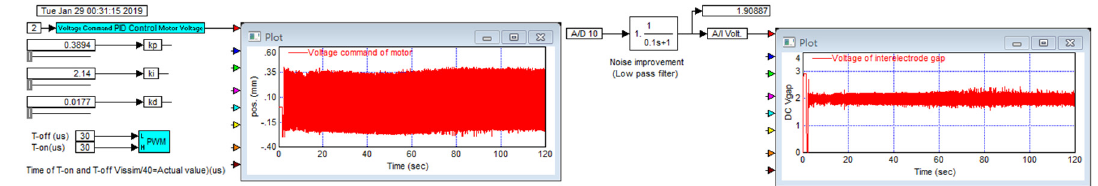
Figure 9. Motor voltage command and IEG voltage signal when the PID–ZN controller was employed to produce colloids.